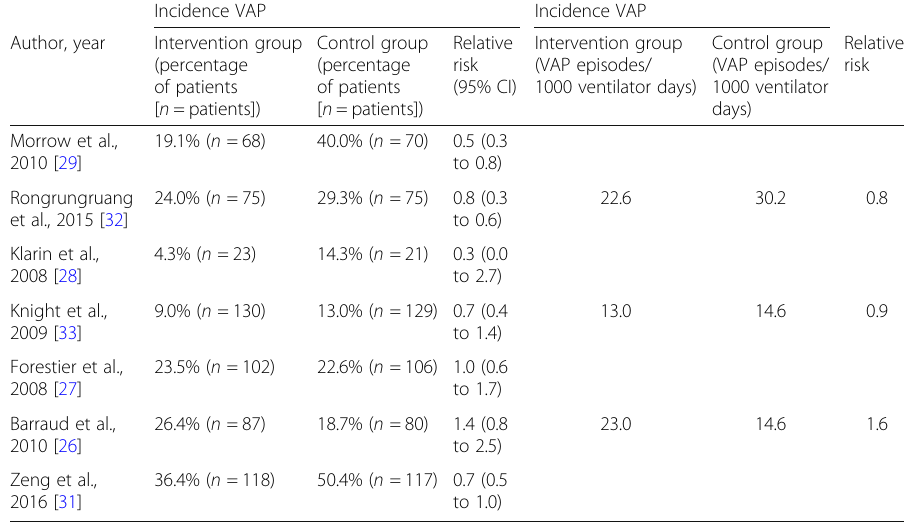
Table 2 Incidence of VAP (percentage of total patients and number of VAP episodes/1000 ventilator